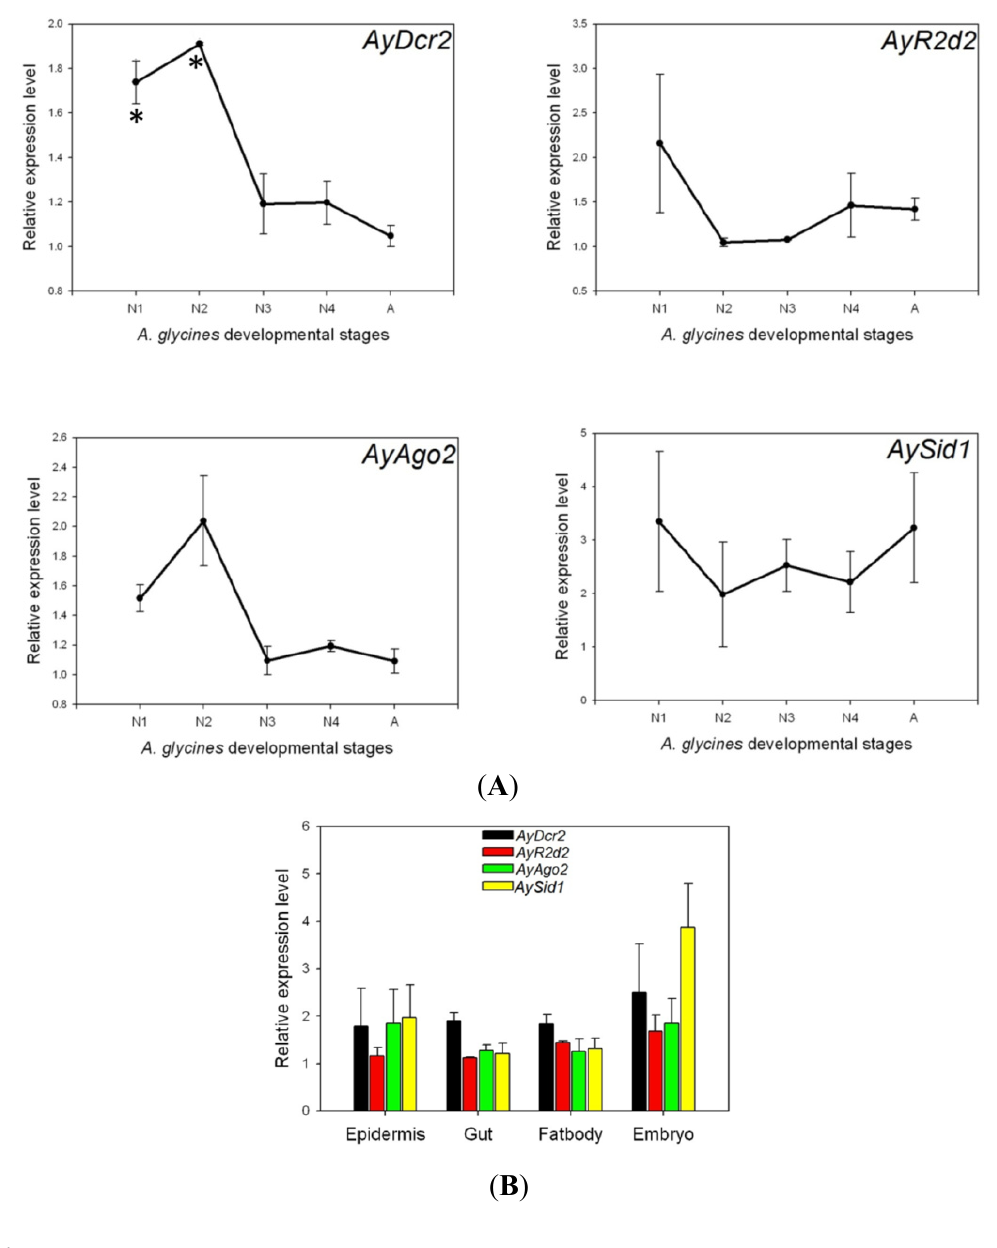
Figure 6. Relative expression levels of AyDcr2 , AyR2d2 , AyAgo2 , and AySid1 in different developmental stages ( A ) and tissues ( B ) of A. glycines as determined by qPCR. The relative expression was calculated based on the value of the lowest expression which was ascribed an arbitrary value of 1. The asterisk (*) represents a significant difference ( p < 0.05) compared to treatment with lowest expression. Different developmental stages are N1-1 st instar nymph, N2-2nd instar nymph, N3-3rd instar nymph, N4-4th instar nymph, A-adult. Different tissues dissected from A. glycines adults are epidermis, gut, fat body and